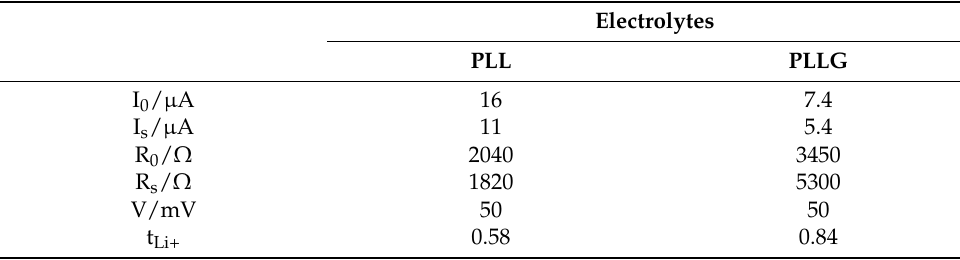
Figure 2. ( a ) Ionic conductivity of PLLG electrolyte membranes, ( b ) X-ray diffraction spectra of PVDF, LATP, graphene, PLL and PLLG electrolyte membranes, ( c ) Li + transference number of PLL electrolyte membrane and ( d ) Li + transference number of PLLG electrolyte membrane. Table 1. Li + transference numbers of PLL and PLLG electrolyte